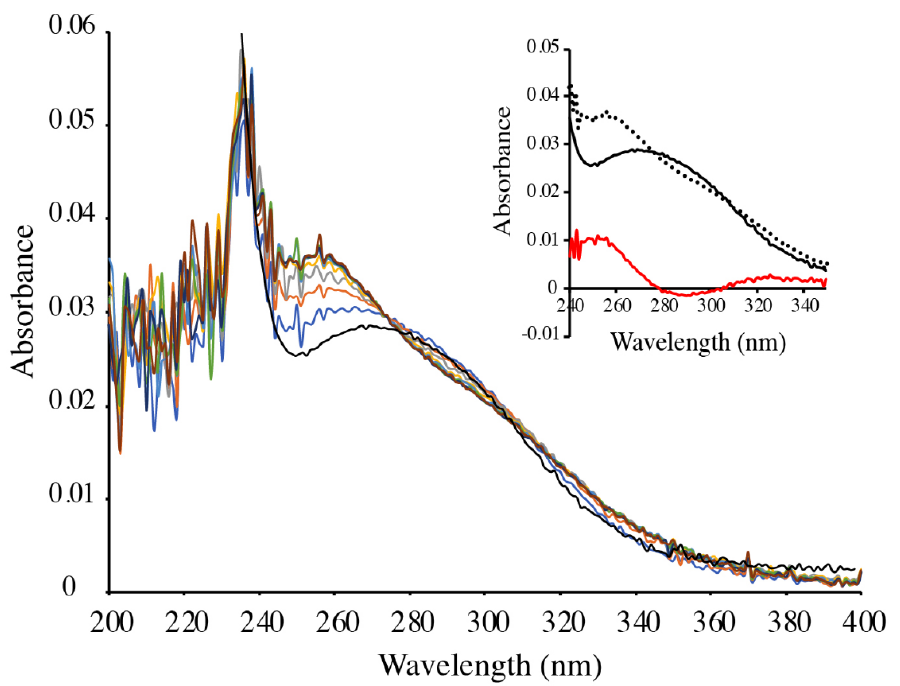
Figure 3. Reduction of MeSeSG by GSH. 100 µM MeSeSG was mixed with 10 mM GSH (containing 150 µM GSSG) in 100 mM potassium phosphate, pH 7.4, and UV absorption spectra were recorded after 20 s (blue line); 60 s (orange); 100 s (grey); 140 s (yellow); 180 s (light blue); 220 s (green); 260 s (dark blue); 300 s (brown). The spectrum of a solution of 100 µM MeSeSG alone is displayed in black. Inset: The spectrum of MeSeSG (black solid line) was subtracted from that of the products of the reaction after 5 min (dotted line) to obtain the difference spectrum (red line).